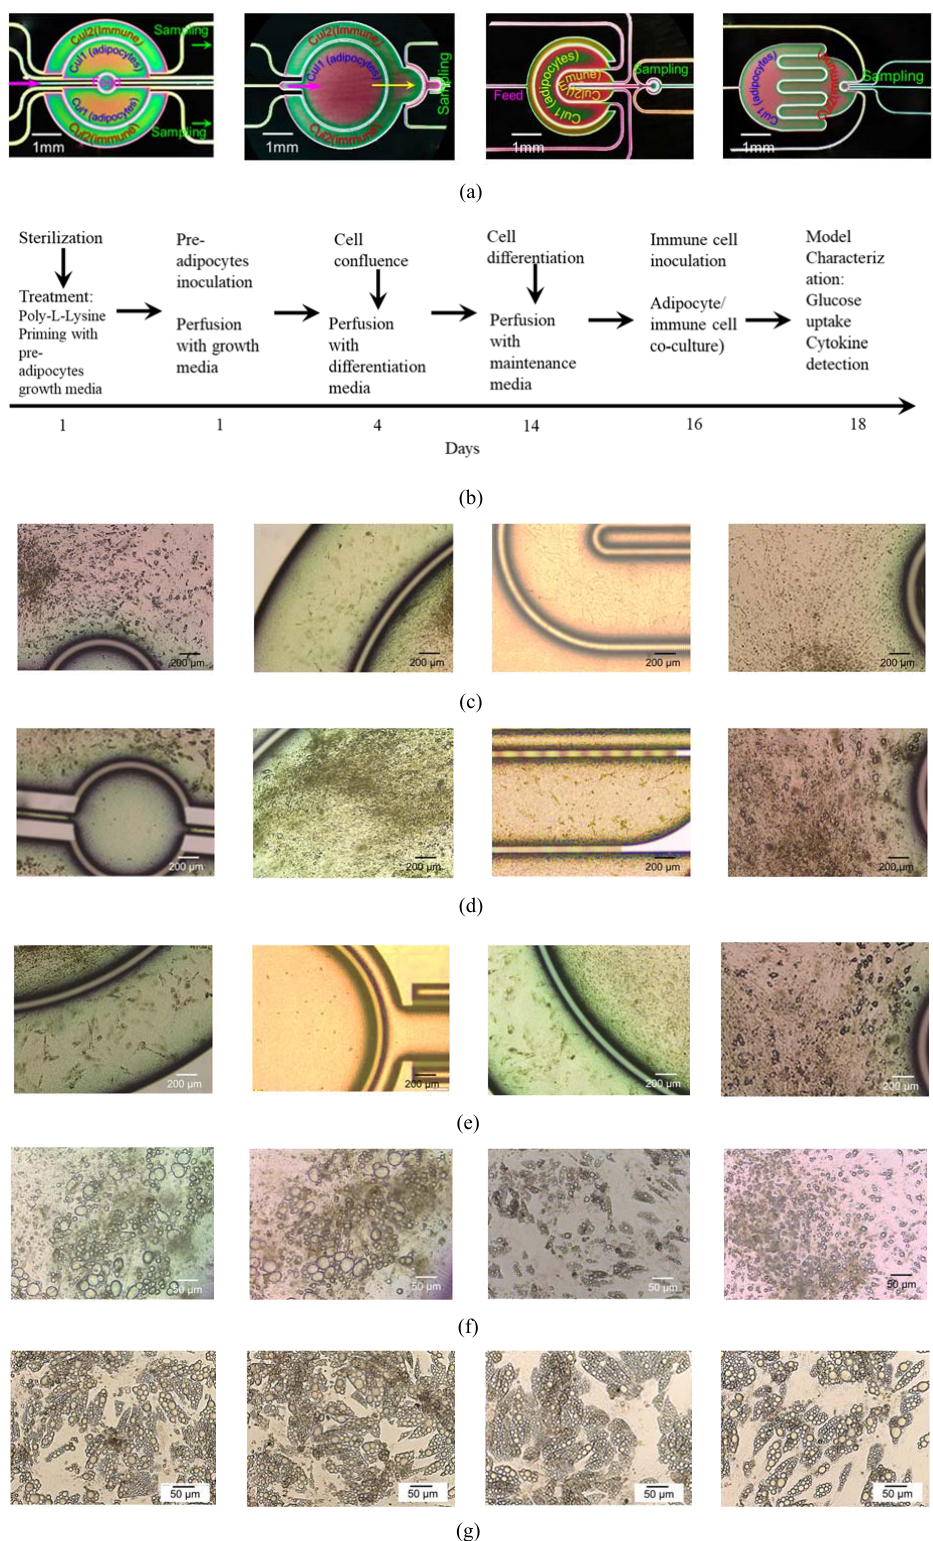
Figure 6. The sequence of adipocyte/immune cells co ‐ culture and optical images of the co ‐ culture over 24 days. ( a ) Chip images with the cell cultutrre designation within the corresponding compartments; ( b ) Summary of experemintal steps of the cell co ‐ culture process; ( c ) Preadipocytes monoculture (5 days); ( d ) Differentiated adipocytes (14 days); ( e ) Adipocytes ‐ immune cell co ‐ culture (16 days); ( f ) Fully differentiated adipocytes (20 days); ( g ) Fully differentiated adipocytes (24 days).